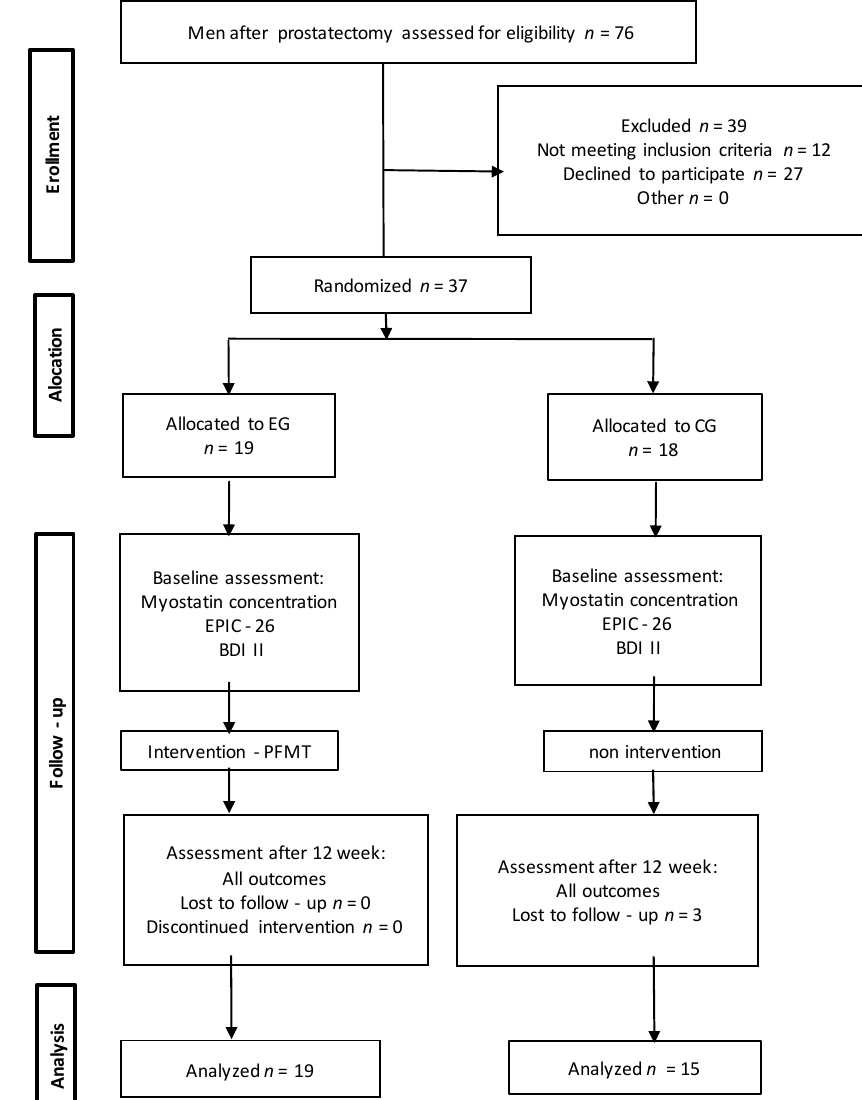
Figure 1. The study flow diagram. EG: experimental group; CG: control group; EPIC-26: Expanded Prostate Cancer Index Composite; BDI -II: Beck’s Depression Inventory; PFMT: pelvic floor muscle training